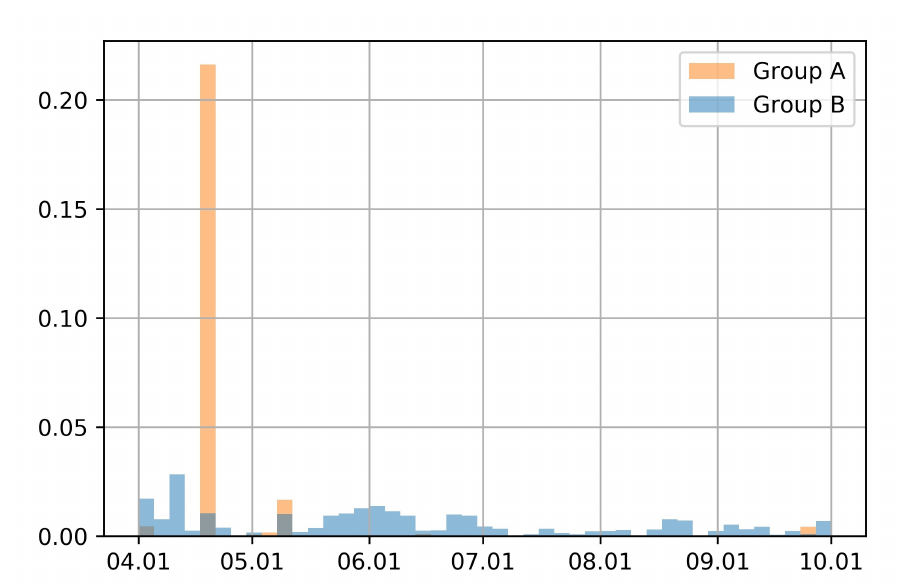
Figure 3. Comparison of the queued job for two groups in